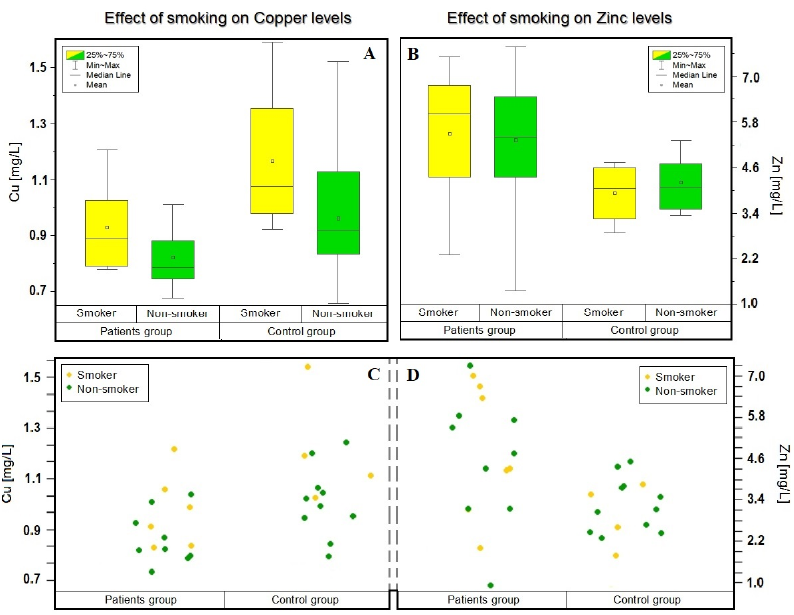
Figure 3. Dependence of the concentration of zinc and copper in the blood of patients and the control group depending on the selected criterion—smoking (In patient group: smoker—yellow; n = 6, non-smoker—green; n = 9. In control group: smoker—yellow; n = 4, non-smoker—green; n = 11.). The mean (circle), median (line), percentile 25, 75 (boxes), and mini- mum and maximum value (whiskers) are shown in ( A , B ). ( A ) Box plot showing the influence of smoking on the concen- tration of copper. ( B ) Box plot showing the influence of smoking on the concentration of zinc. The visualizations in ( C , D ) were inspired by the t -test, i.e., they are an attempt to compare the means of two finite research samples with selected criteria. ( C ) Shows visualizations of the distribution of copper concentrations considering the smoking criterion. ( D ) Shows visualizations of the distribution of zinc concentrations considering the smoking criterion.